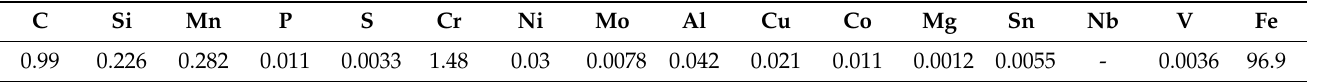
Table 4. Chemical composition of steel 14,109 in percentage by